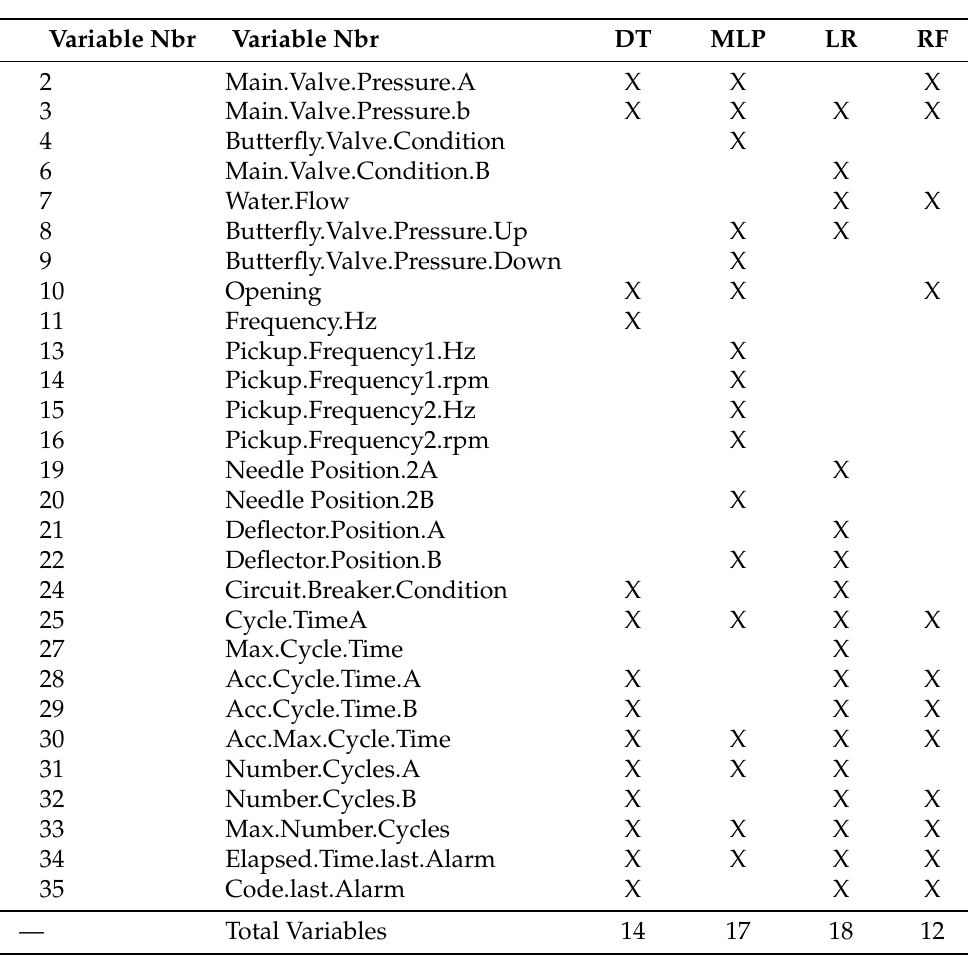
Table 4. MIV per Model